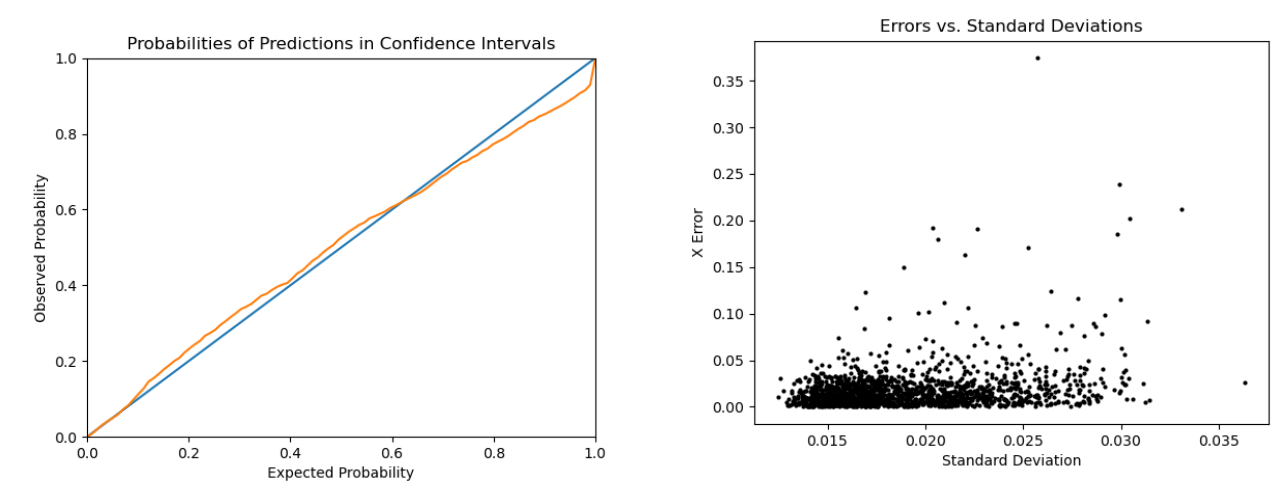
Figure 4. Comparison of uncertainty calibration between an accurate model and a less accurate model. The units in ( b , d ) are normalized over the unit square ROI. The first model, shown in parts ( a , b ), had an average error of 149 m. It has poor uncertainty calibration; more of the true centers are contained in a given percent confidence interval than expected, meaning the model is underconfident. The second model, shown in ( c , d ), was incompletely trained, and only achieved an average error of 965 m. However, it showed better uncertainty calibration. Note, however, that some of the error sizes are unrealistically large given the standard errors, indicating the true uncertainty distribution is not